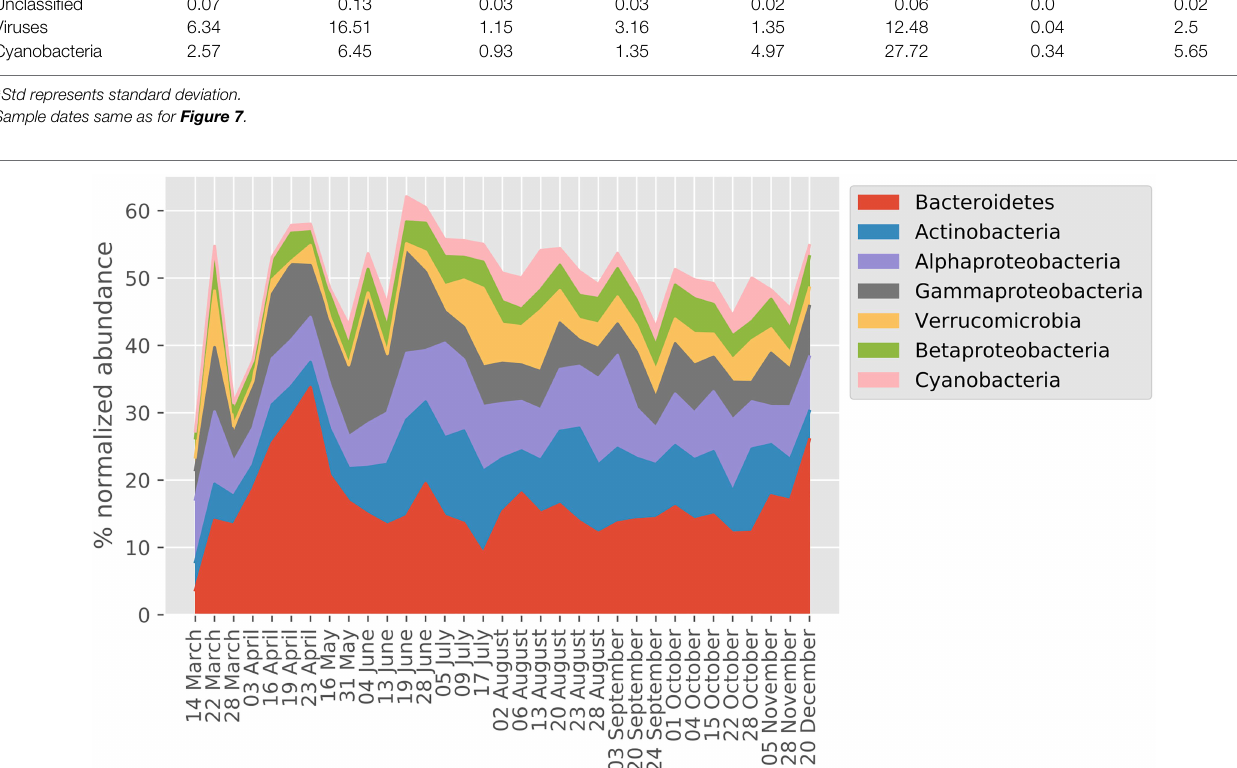
FIGURE 2 | Prokaryote taxonomic profile derived from normalized abundance in the LMO metagenome (MG) dataset (year 2012). The percentage of the seven phyla/classes with highest mean across sampling dates are shown.